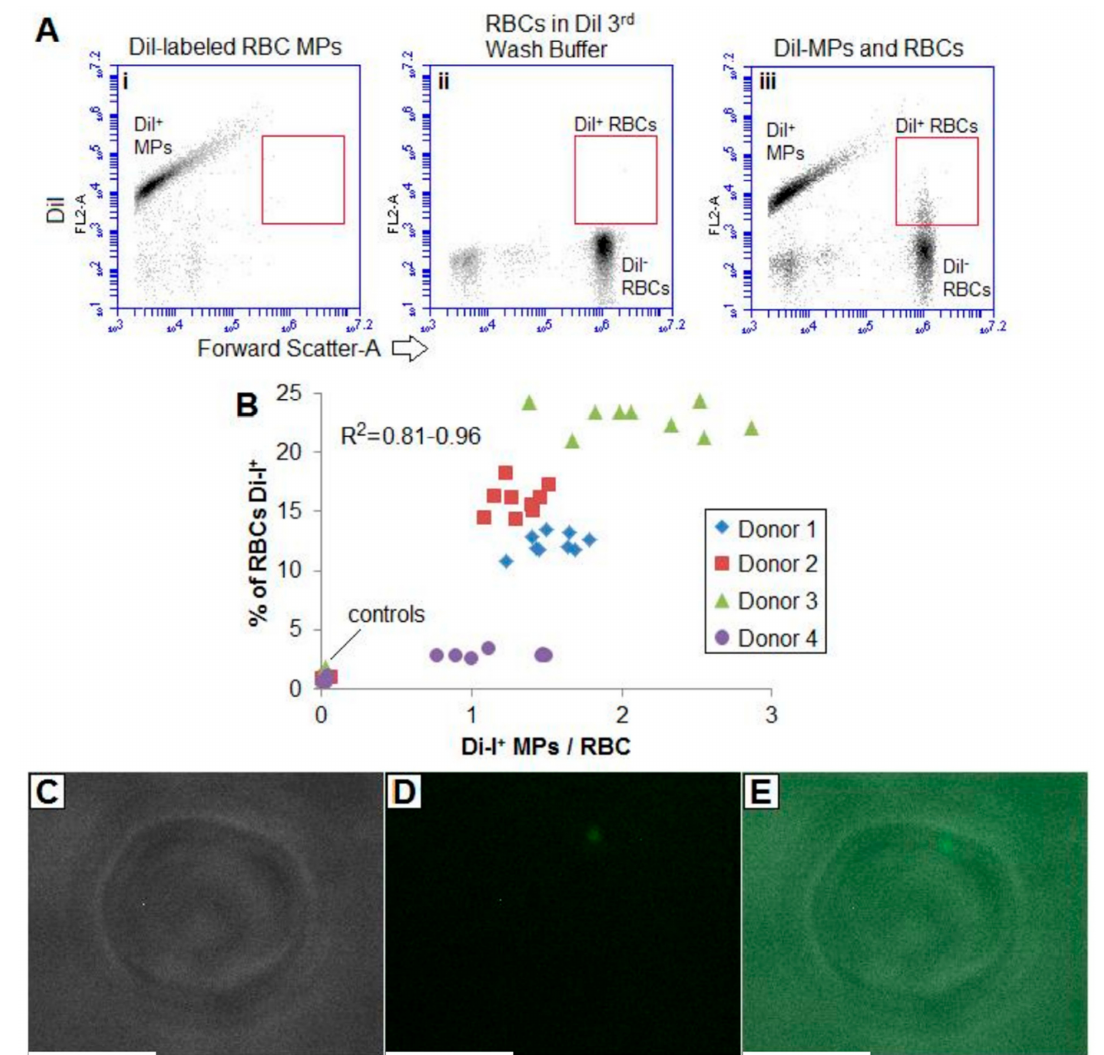
Figure 6. Fluorescent lipid-labeled MPs/MVs adhered to RBCs. ( A ) To further investigate the discrepancy between RMV concentrations found in direct dilutions of blood compared to RBC-poor supernatant isolated by sedimenting cells overnight, isolated MVs were labeled with DiI and washed 3x (i). The 3rd wash buffer (with any unbound dye) was used to resuspend washed RBCs (ii). When the DiI-MVs were incubated with unlabeled washed cells, there appeared to be DiI-positive RBCs (iii). ( B ) Normalized to the total cells, there was a DiI-MV concentration-dependent increase in DiI-positive cells. ( C ) Light micrograph of an RBC, with corresponding ( D ) DiI-fluorescence and ( E ) overlay show apparent MV adhered to an otherwise normal-appearing RBC. Bar = 5 µ